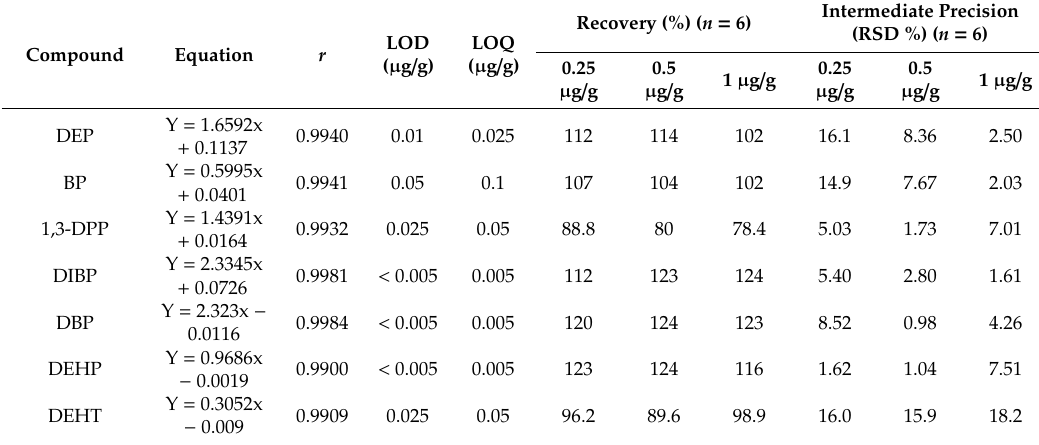
Table 3. Method validation parameters